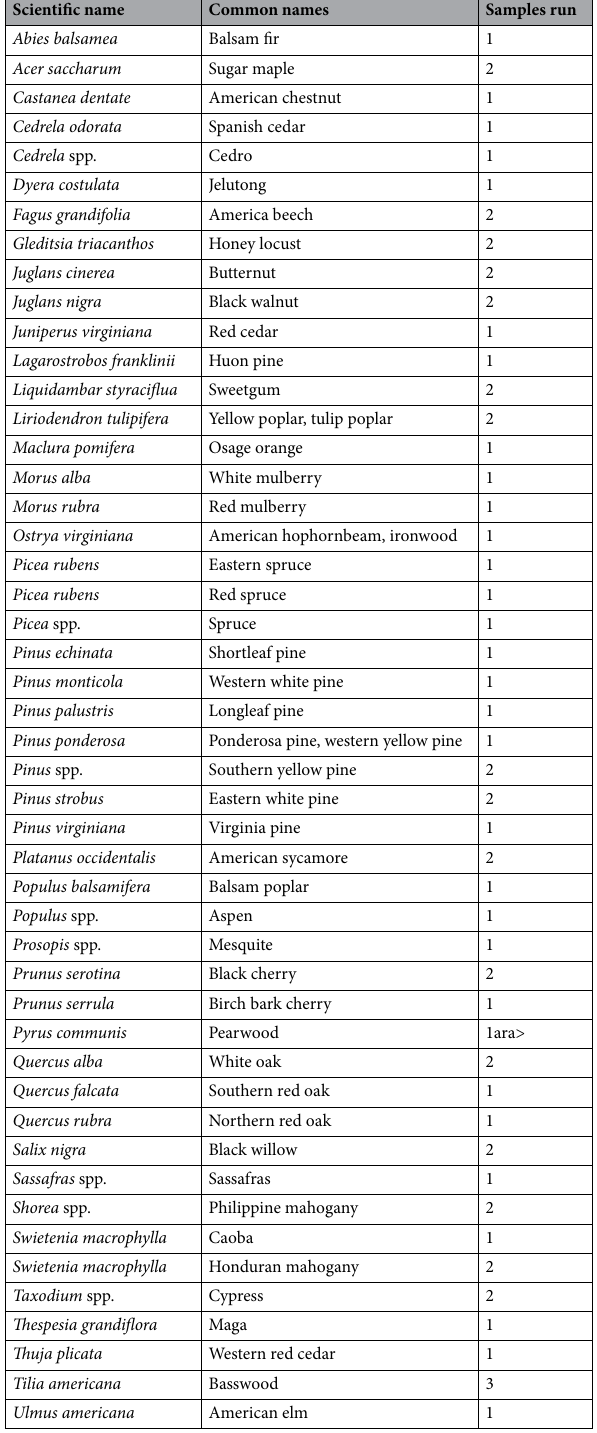
Table 1. List of wood species analyzed and the number of samples run for